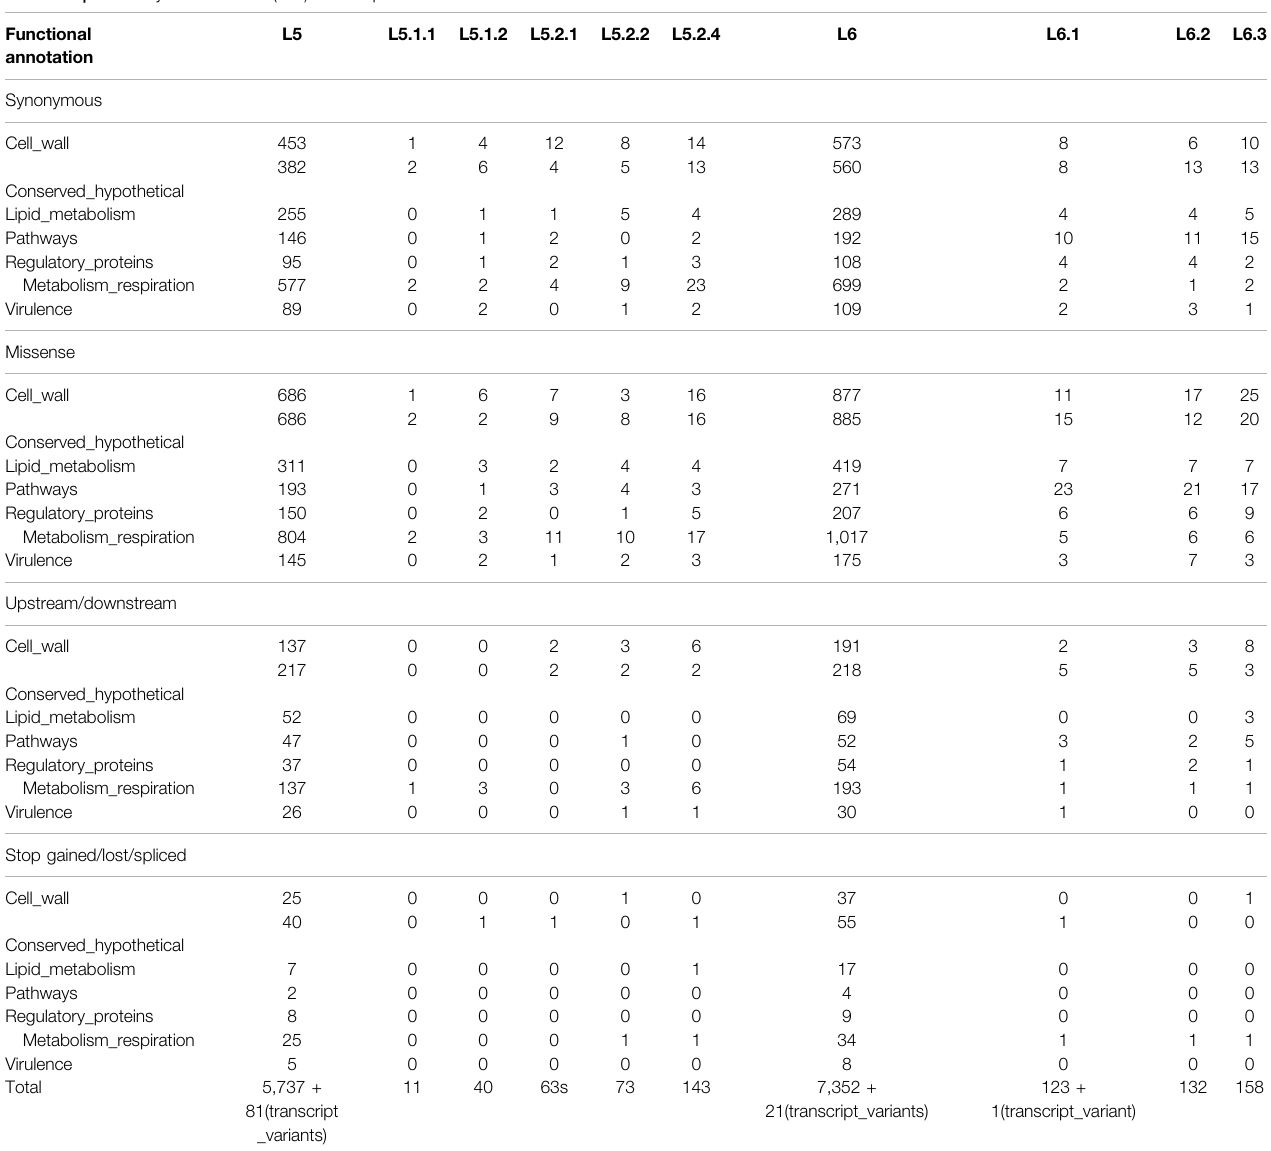
TABLE 3 | Summary of L5 and L6 (sub)cluster-speci fi c-core SNPs. Functional